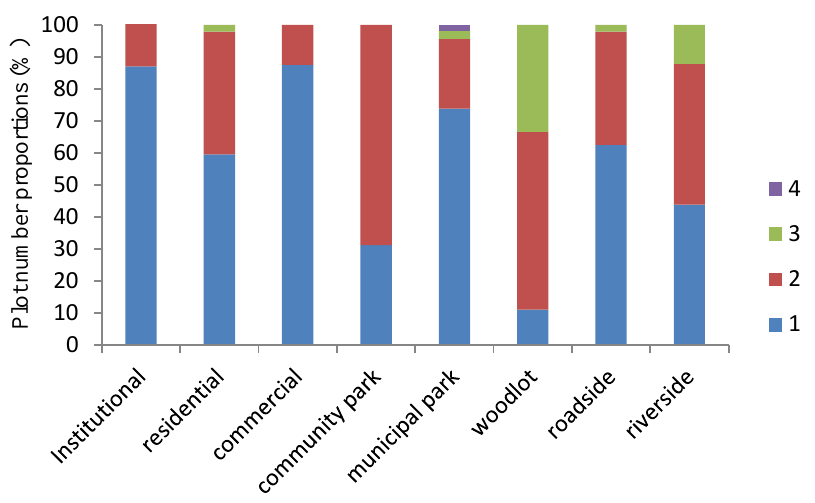
Figure 6. Distribution of pollen allergenic ruderal species by number in each plot for different LUTs.